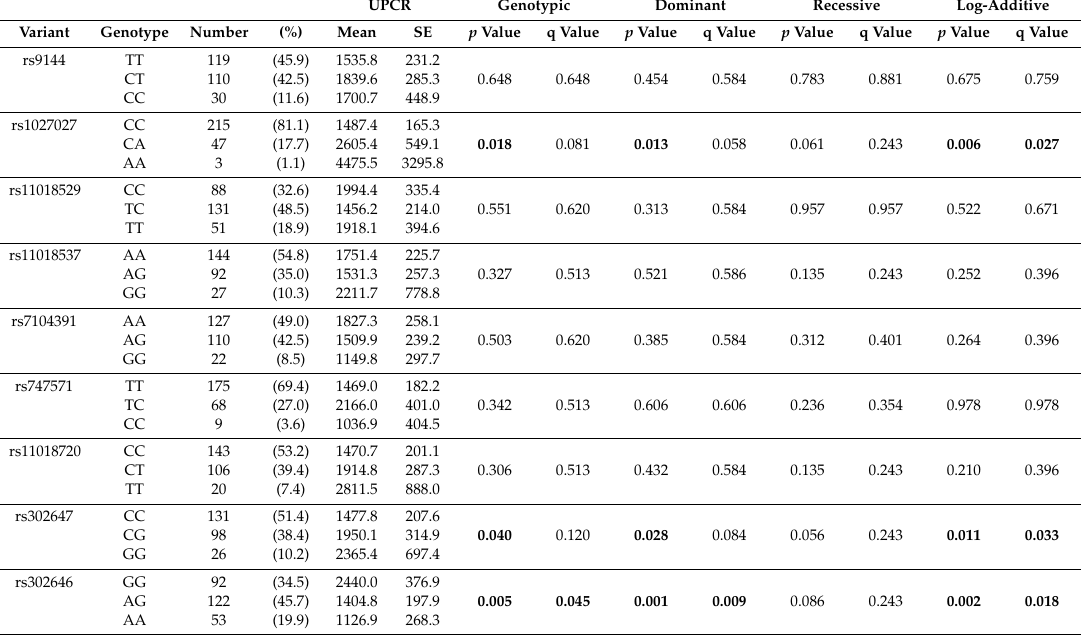
Table 3. Association analysis between RAB38 single-nucleotide polymorphisms (SNPs) and the urine protein and creatinine ratio (UPCR). UPCR Genotypic Dominant Recessive